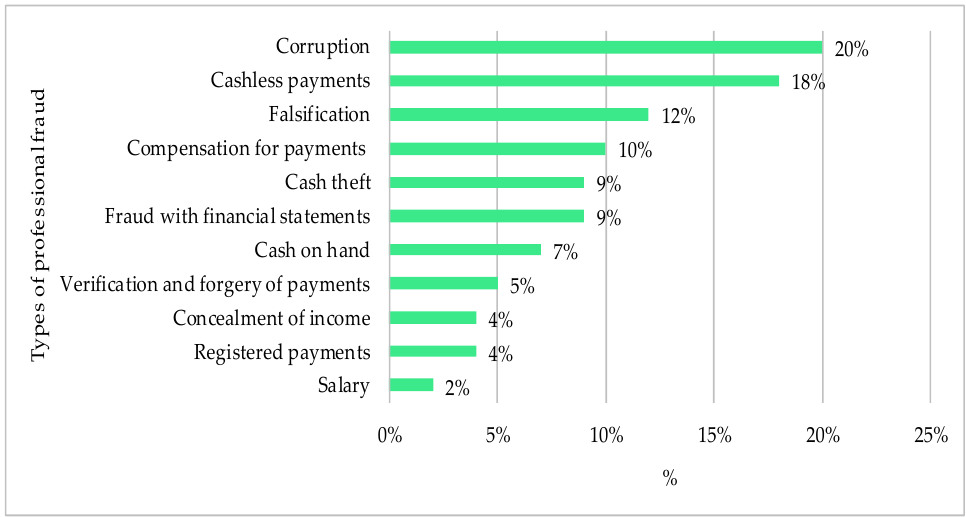
Figure 4. Most common professional fraud schemes in Eastern Europe and Western/Central Asia. Source: based on Occupational Fraud 2022, a report to the nations.